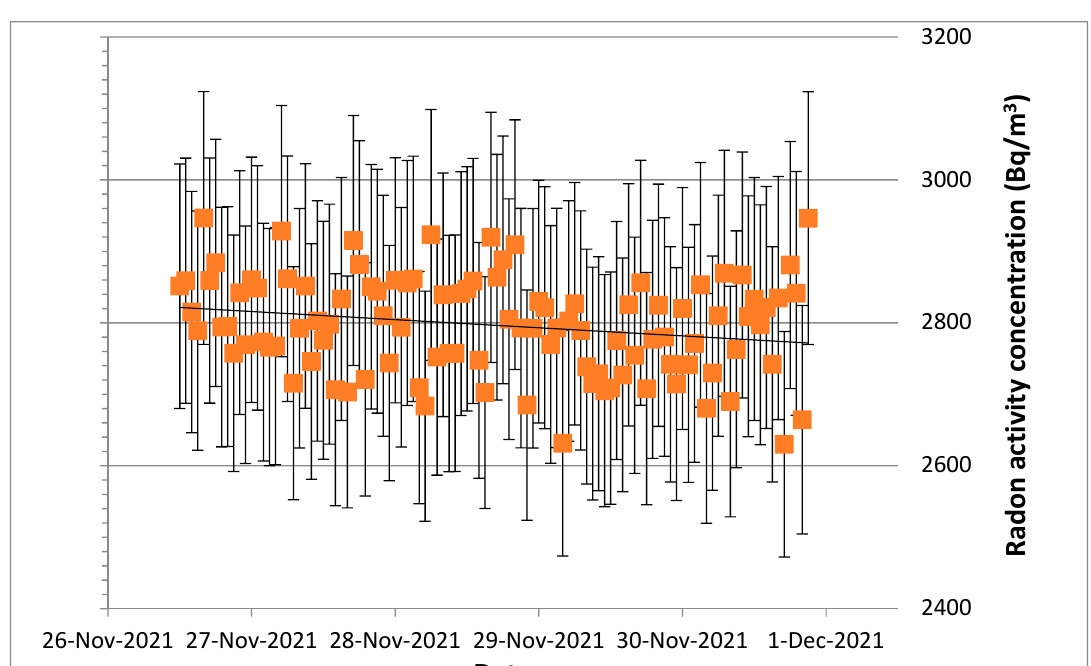
Figure 7. Evolution of the radon activity concentration in the radon chamber, as indicated by the AlphaGuard DF2000 monitor (all the data are calculated at the reference date and time of 26 November 2021, 12:00 h (UTC + 2)).